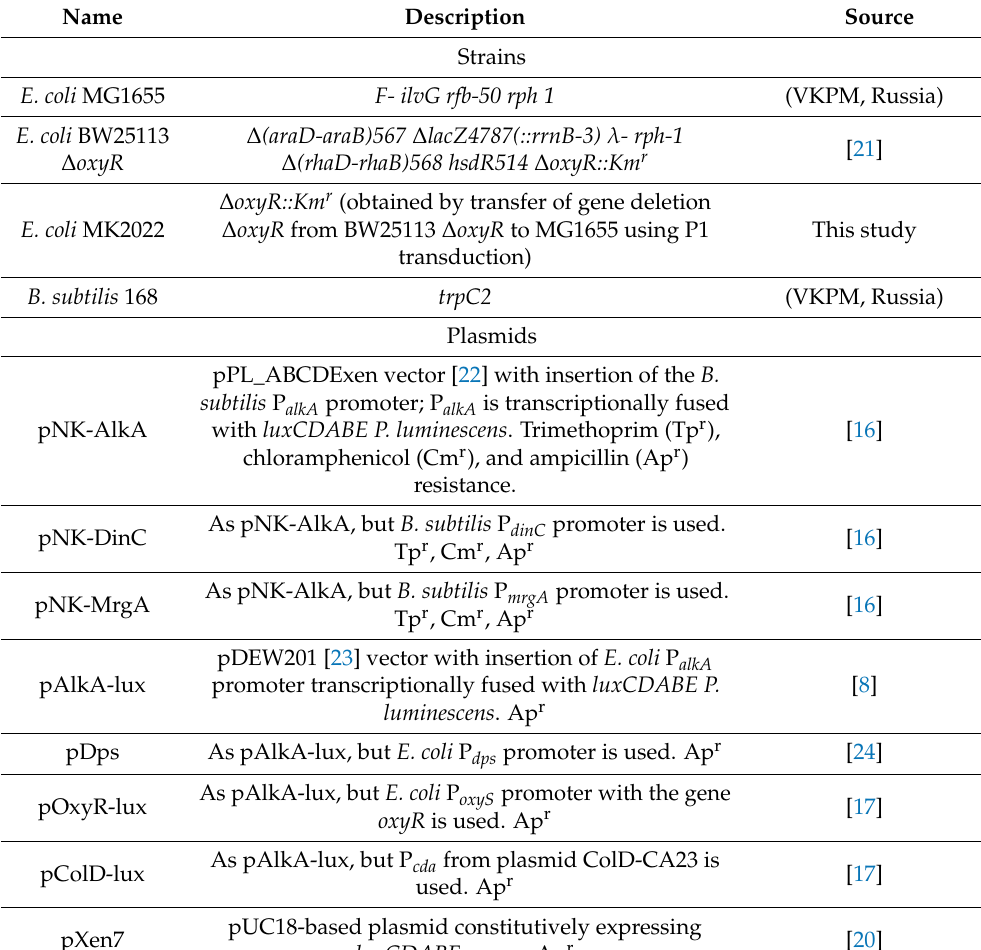
Table 1. Bacterial strains and plasmids used in the